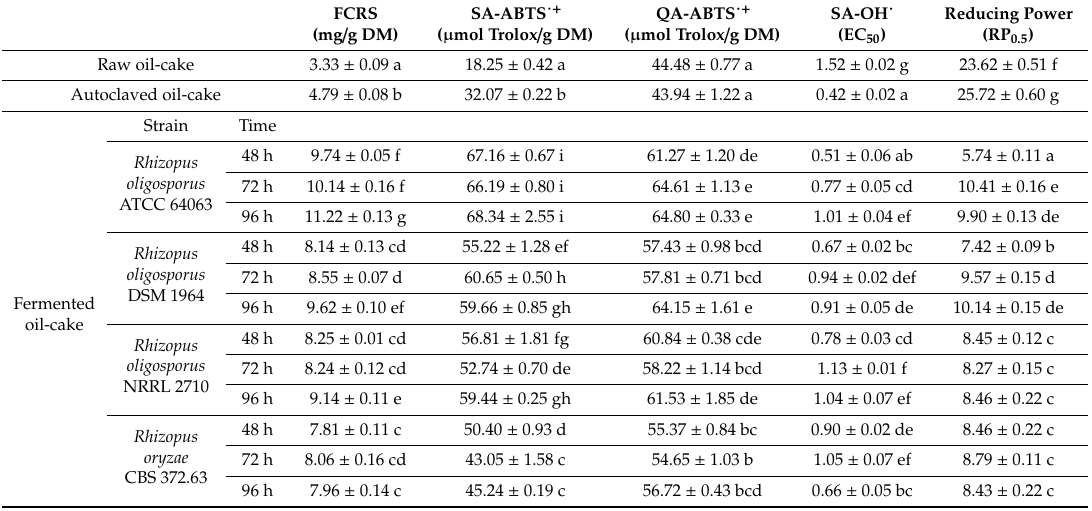
Table1. Antioxidantactivityofpumpkinoil-cake—raw, autoclavedandfermentedwith Rhizopus